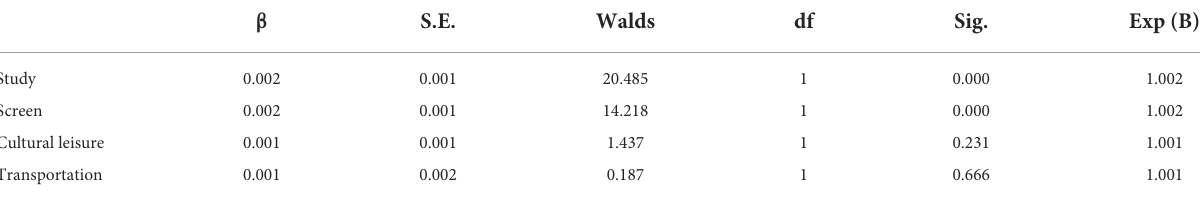
TABLE 15 Binary logistic regression results of the effects of various sedentary time on visual acuity.